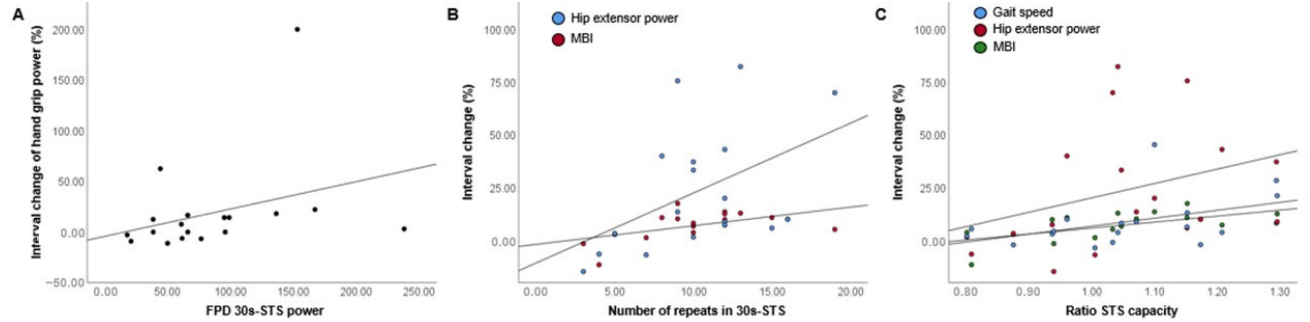
Figure 3. Scatter plots for FPD 30s-STS power, number of repeats in FPD-30s-STS, STS capacity, and significantly improved variables. ( A ) Scatter plot for FPD 30s-STS power and interval change of hip extensor power, and hand grip. ( B ) Scatter plot for the number of repeats in 30s-STS, hip extensor power interval change, and MBI. ( C ) Scatter plot for STS capacity ratio, gait speed interval change, hip extensor power, and MBI.